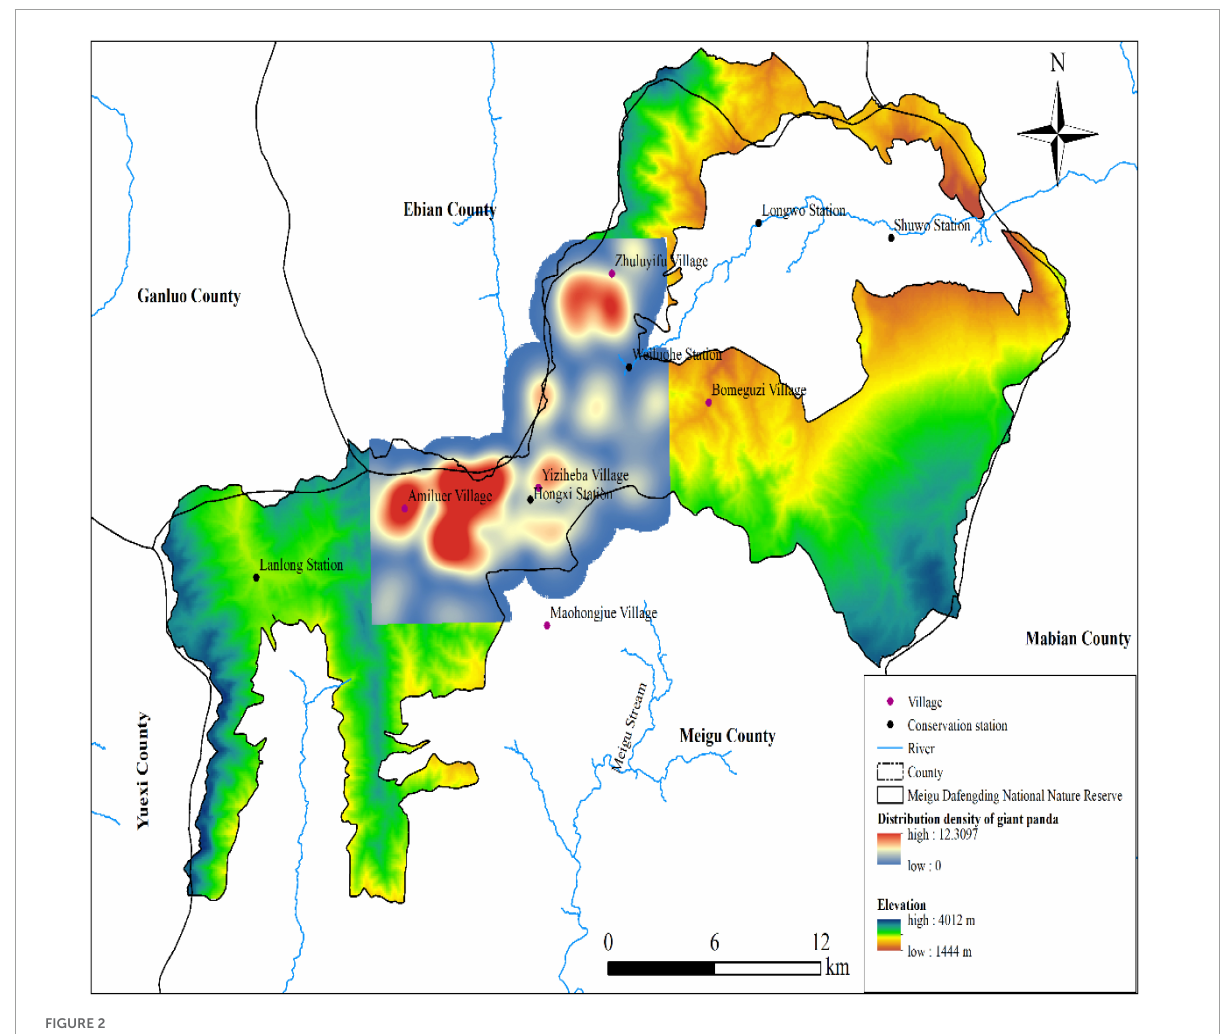
FIGURE2 Core distribution zones of giant pandas in the study